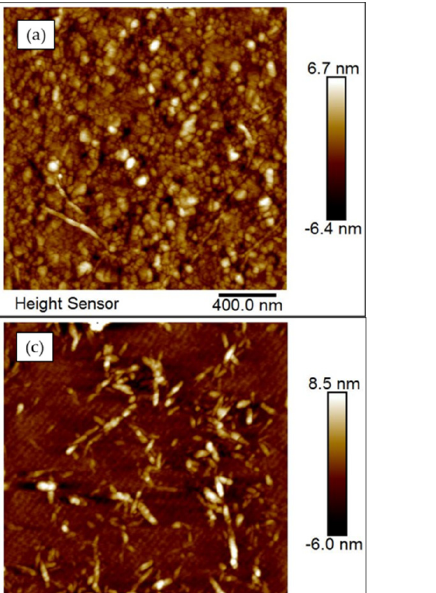
Figure 10. SPR reflectance curve for GO-PVA thin film in contact with various concentrations of carbaryl (0.02 ppb to 0.06 ppb). 4. Discussion In the FTIR spectrum of GO-PVA thin film, the main functional group in GO and PVA elements such as C=O stretching, C=C stretching, -CH 2 stretching, C–O stretching, and O–H stretching were obtained, which indicated the interaction for both elements. To further reinforce this point, the formation of hydrogen bonding in the GO–PVA thin film will be emphasized. Basically, O–H stretching bands are sensitive to hydrogen bonds [157,158]. Therefore, the results of this study can conclude that the presence of hydrogen bond interaction with oxygen-containing GO and hydroxyl groups on the PVA chain is detrimental to the hydrogen bond between the PVA chains. It can be seen in Figure 3, the